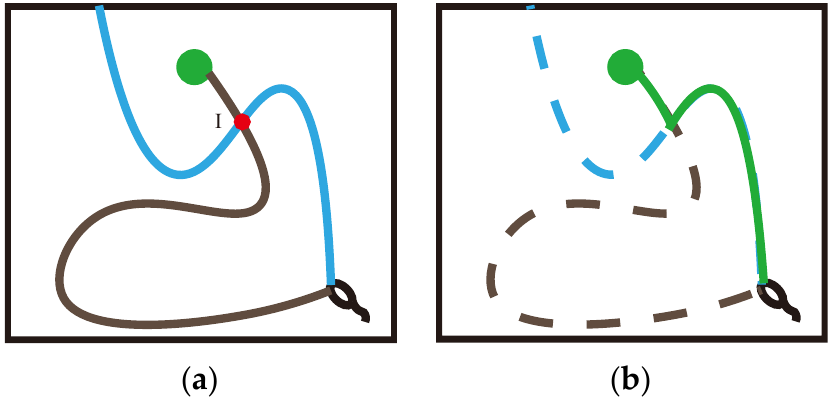
Figure 6. A schematic diagram of one intersection: ( a ) the two trajectories recorded in memory vault M during the agent’s exploration of the environment; the blue trajectory is the low-reward trajectory, the black trajectory is the high-reward trajectory, and the two trajectories intersect at point I . ( b ) According to the Memory-Replay Mechanism we described, using the intersection as the dividing point and two real experienced trajectory sequences as the basis, construct a virtual path that the agent has never navigated. Algorithm 1. The Memory-Replay Mechanism.